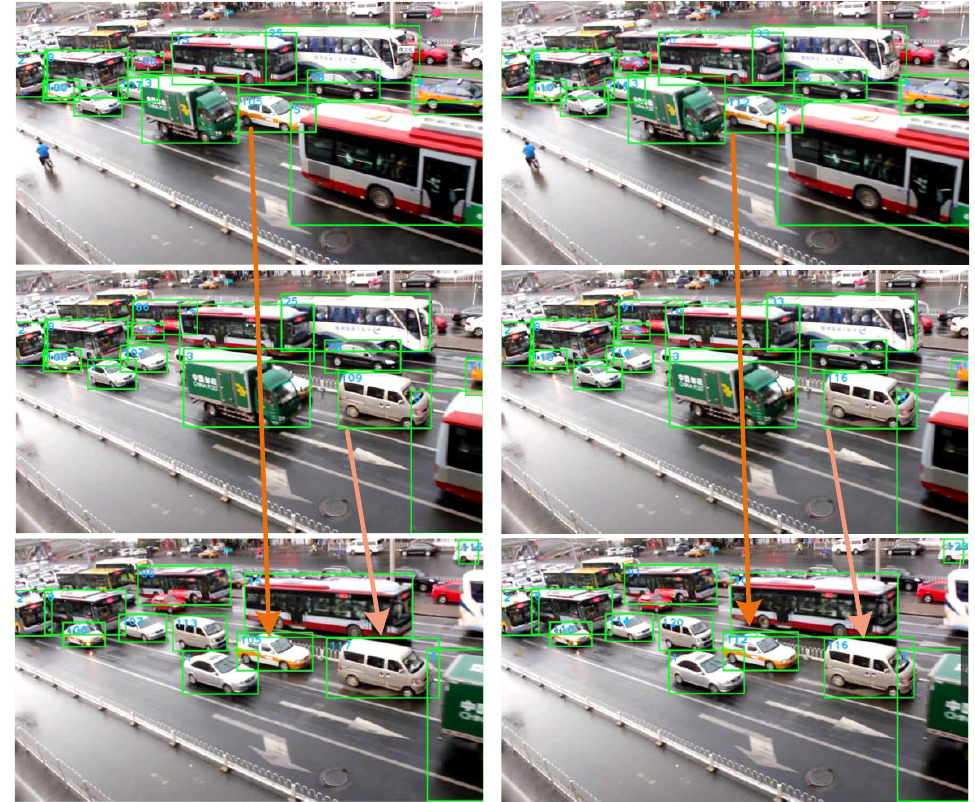
Figure 17. Comparison of tracking results before and after reidentification training. Table 6. Ablation experiment of re-id